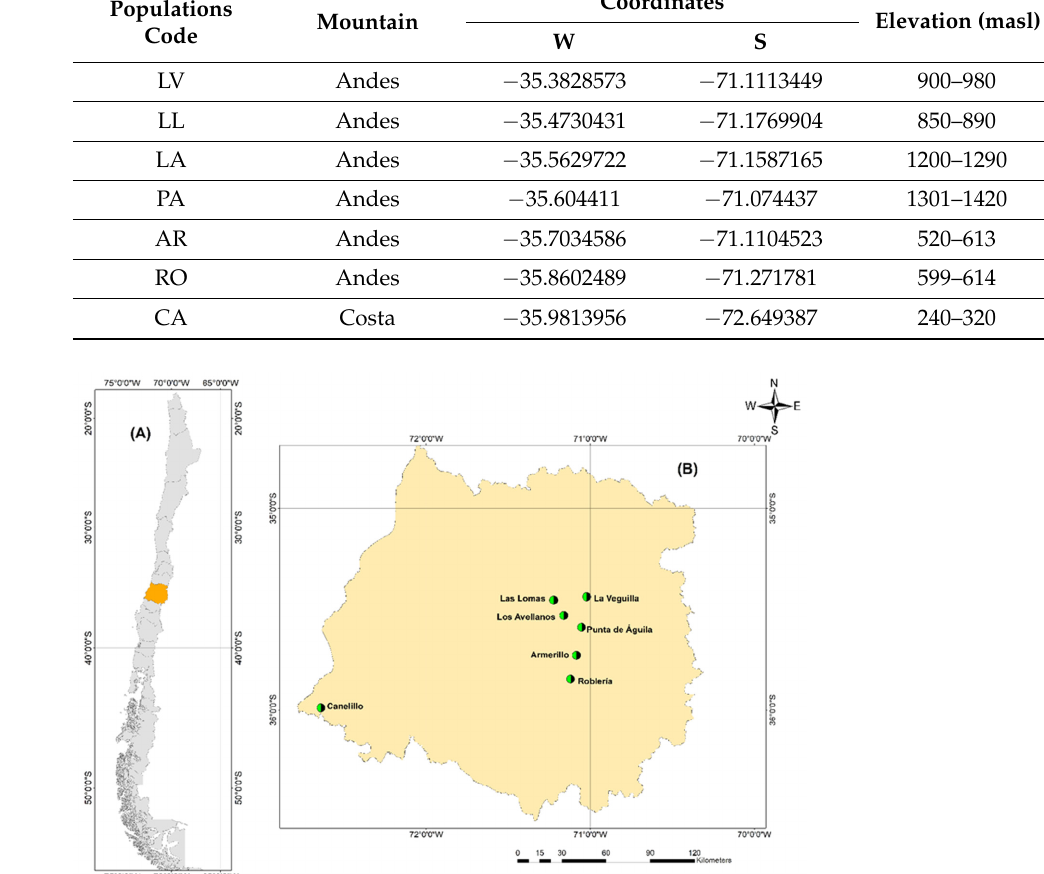
Figure 2. Maps showing geographical locations where samples were collected. ( A ) Study area in Chile named the Region of Maule (orange area on the map). ( B ) The marked points are exact points of collection sites of the seven populations of Gevuina avellana Mol. Table 1. Plants material collected sites of the seven populations of G. avellana Mol. used in the study. Location distributed from north to south: La Veguilla (LV), Las Lomas (LL), Los Avellanos (LA), Punta de Águila (PA), Armerillo (AR), Roblería (RO), and Canelillo (CA). Populations Code Mountain